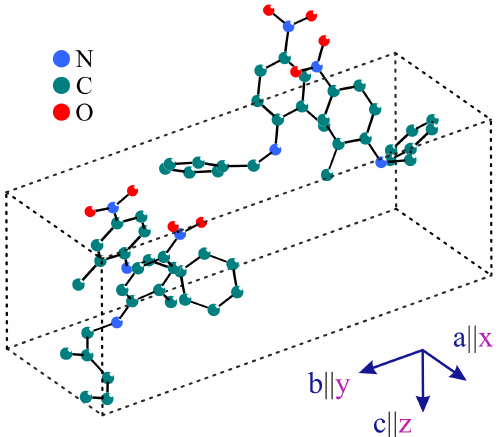
Figure 18. Crystal structure of orthorhombic BNA (the .cif files taken from the CCDC database can be found in the Supplementary